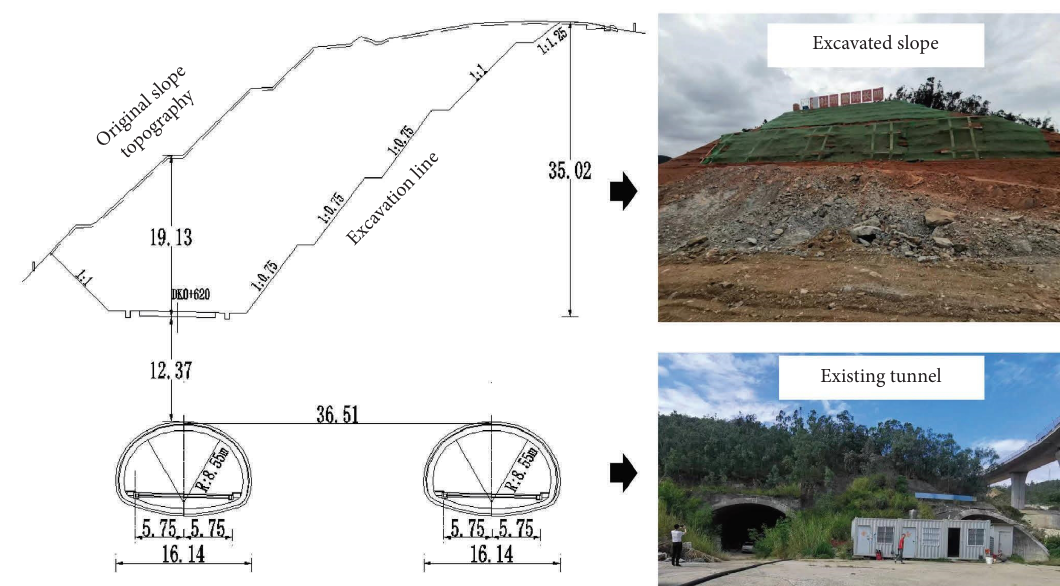
Figure 3: Relationship between the existing tunnel and slope (unit: m).